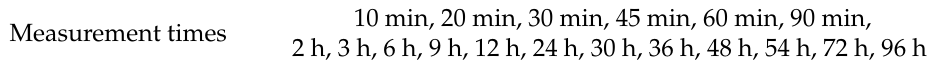
Table A1. List of measurement times. At each measurement time, the sample is excited a minimum of 15 times, obtaining at least 15 repeats of the sinusoidal curve plotted in Figure 2 used to calculate the material properties.